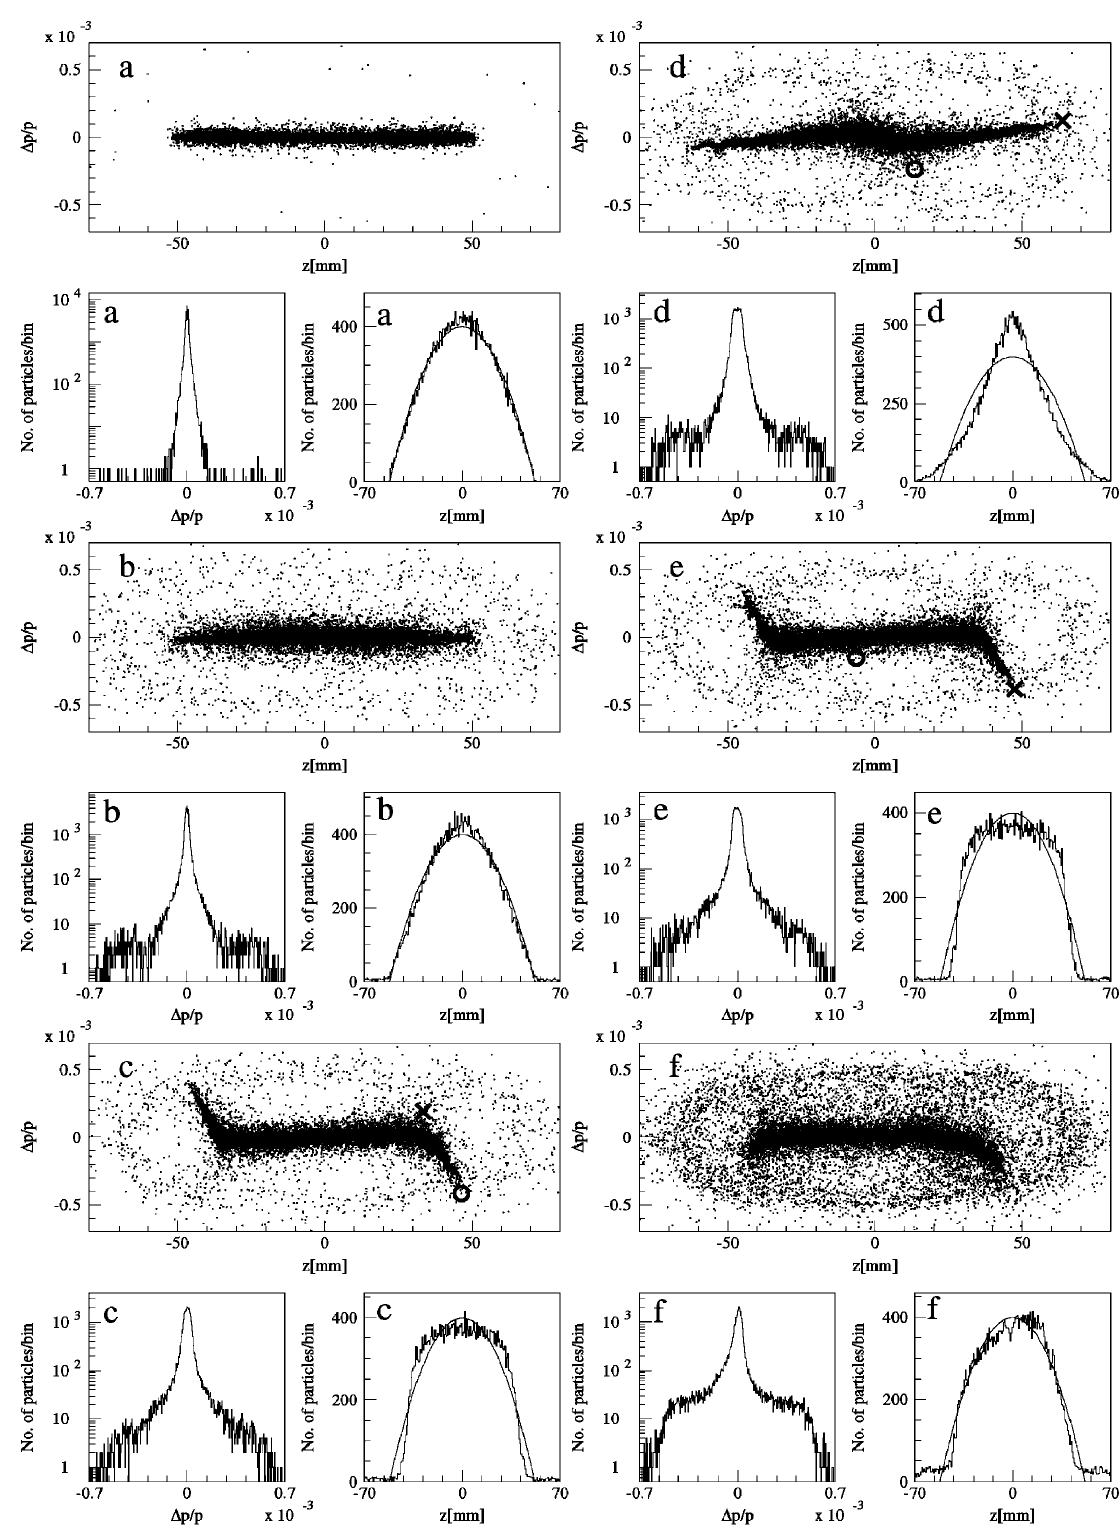
FIG. 9. Longitudinal phase-space distributions during the longitudinal instability. The figures (a) are ones just before the longitudinal instability or at 76.1 ms when the momentum spread ( 6 (cid:30)p=p ) is 1 : 5 (cid:11) 10 (cid:3) 4 . The figures (b) are ones at 116.2 ms, the figures (c)–(e) snapshots taken at each revolution interval at 116.4 ms, and the figures (f) ones at 117.3 ms, when 6 (cid:30)p=p is 3 : 9 (cid:11) 10 (cid:3) 4 at the minimum, 5 : 0 (cid:11) 10 (cid:3) 4 , and 7 : 8 (cid:11) 10 (cid:3) 4 at the maximum, respectively. The parabolic curve fitted to the bunch profile (a) is drawn in (a)–(f). Two particles are marked with (cid:18) and (cid:11) , respectively, in